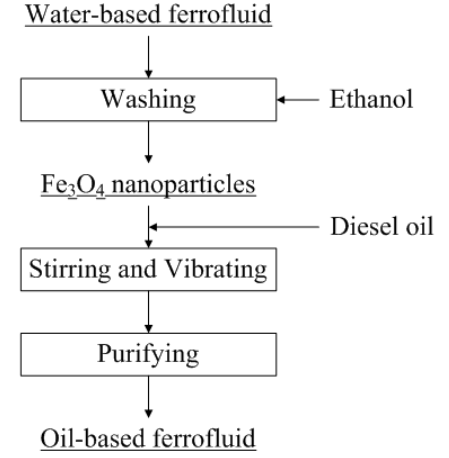
Figure 3. The procedure of phase transferring from water to oil.